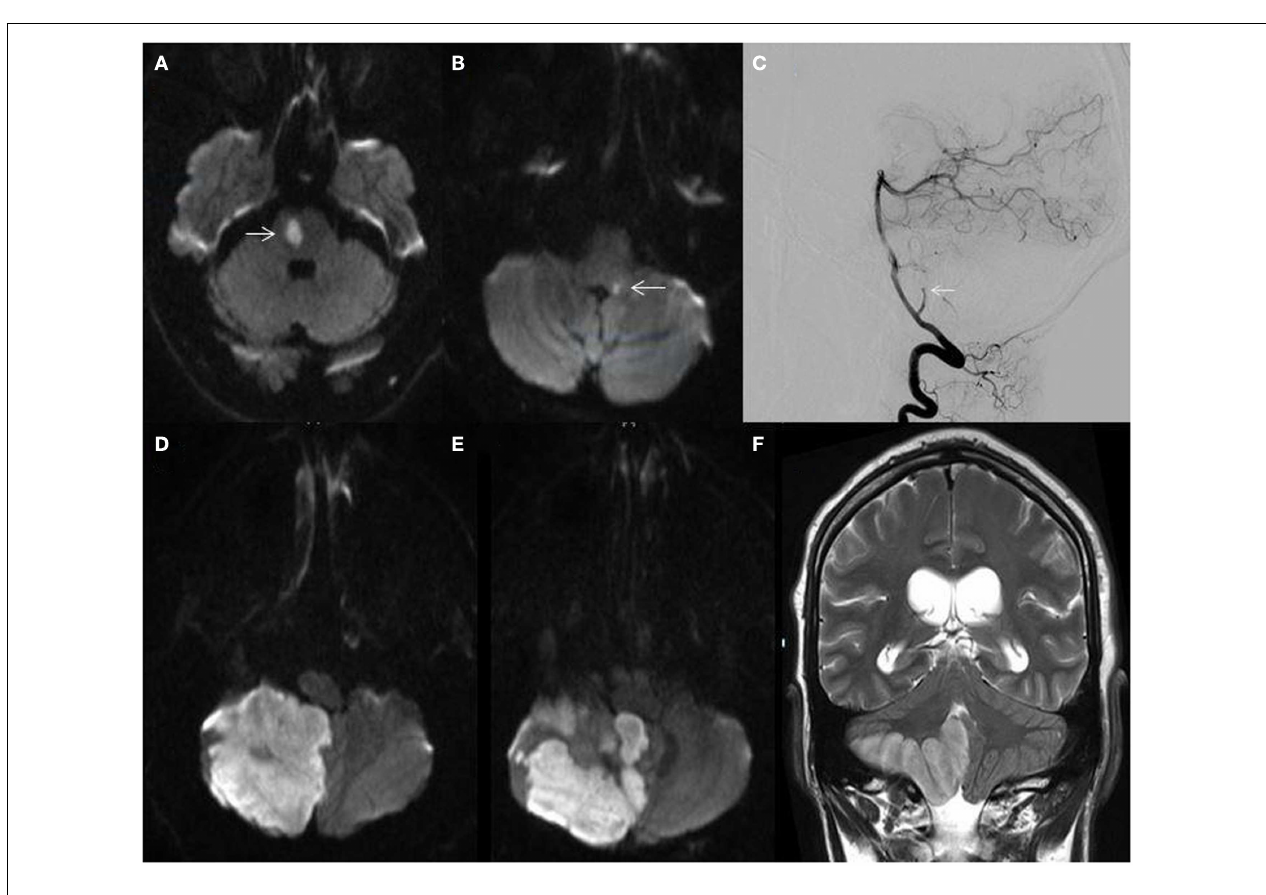
vertigo; (C) catheter angiogram showing cut-off of the right posterior inferior cerebellar artery (arrow); (D,E) MRI-DWI showing massive right cerebellar hemispheric and vermian infarction; (F) MRI T2-weighted sequence demonstrating right cerebellar infarction with edema and mass